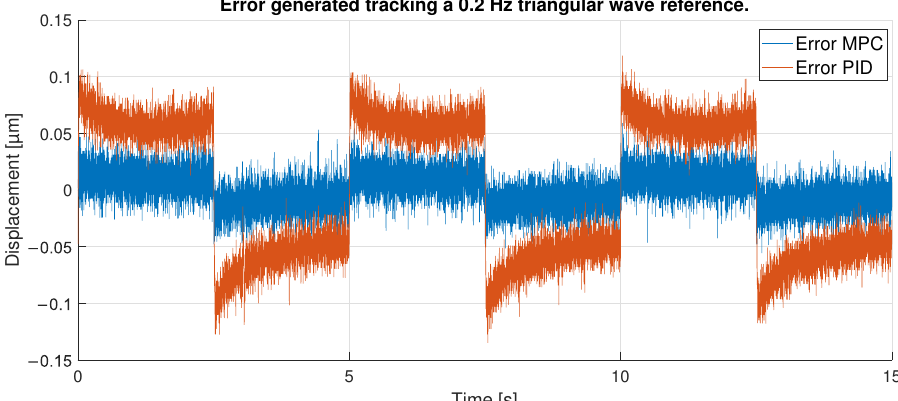
Figure 19. Error of tracking of the PID and MPC for a 0.2 Hz triangular